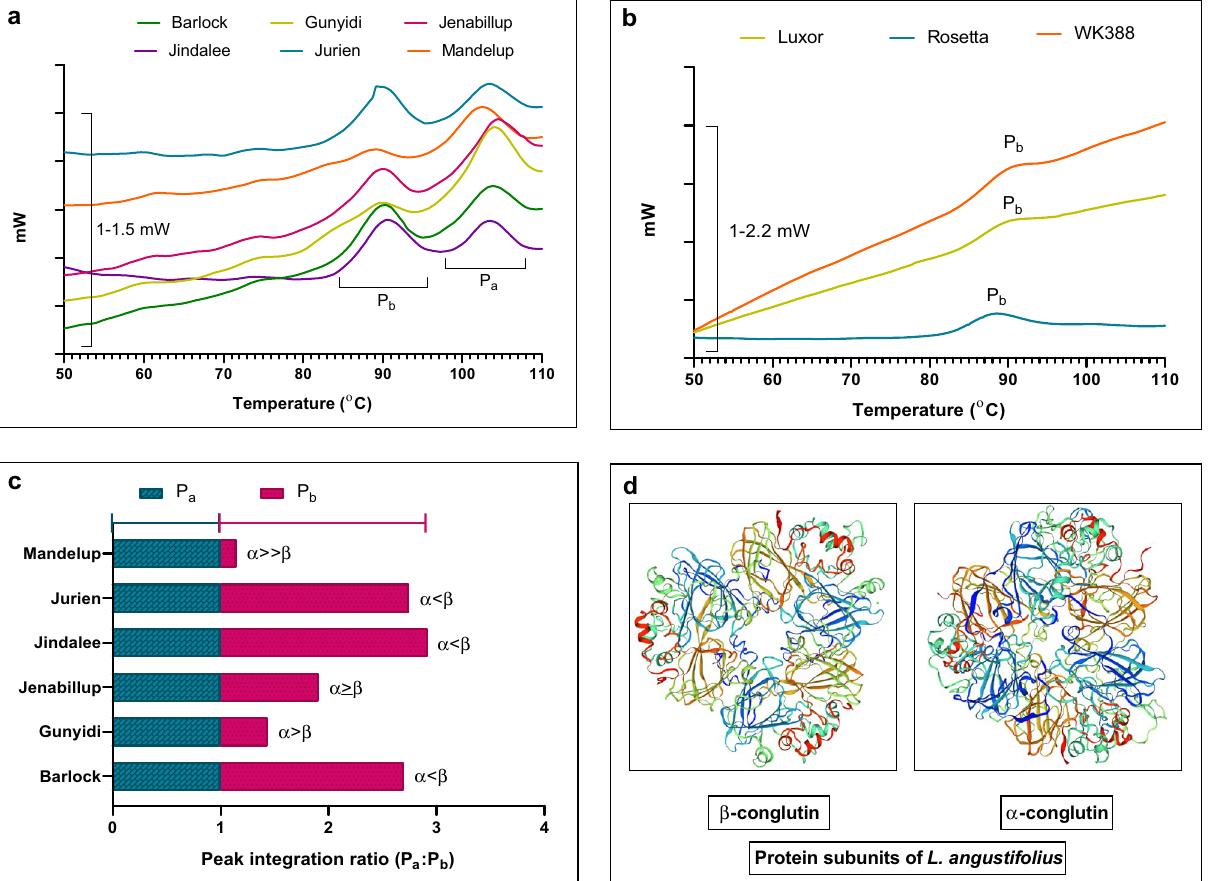
Figure 3. DSC analysis of lupin flours of different cultivars showing presence of β- and α-conglutin; where ( a ): shows the thermograms for the L. angustifolius cultivars, ( b ): shows the thermograms for the L. albus cultivars, ( c ): bar graph depicting the endothermic peak integration ratio (P a :P b ), where P a is the integration of α-conglutin and P b is the integration of β -conglutin. Here, ( d ) is presenting the structures of β- and α-conglutin proteins obtained using the SWISS-MODEL. DSC analysis was carried out in triplicates.